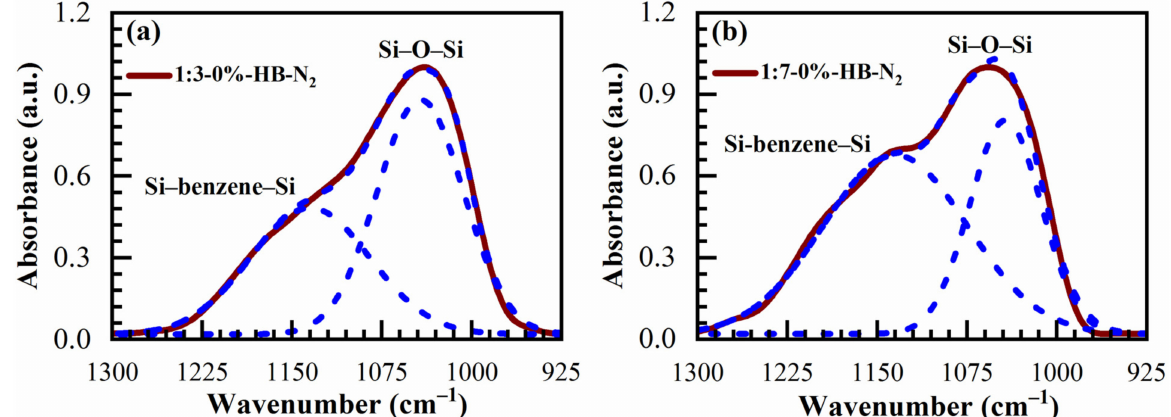
Figure 6. Deconvoluted FTIR spectra in the range of 1300–925 cm − 1 for the completely cured ( a ) 1:3, and ( b ) 1:7 materials cured in N 2 for 60 min (HB-N 2 ). It can be seen that the spectra are deconvoluted into two peaks related to Si–O–Si vibration at 1043 cm − 1 and also from the bond of Si with benzene ring at 1135 cm − 1 because of the presence of benzene bridges in our